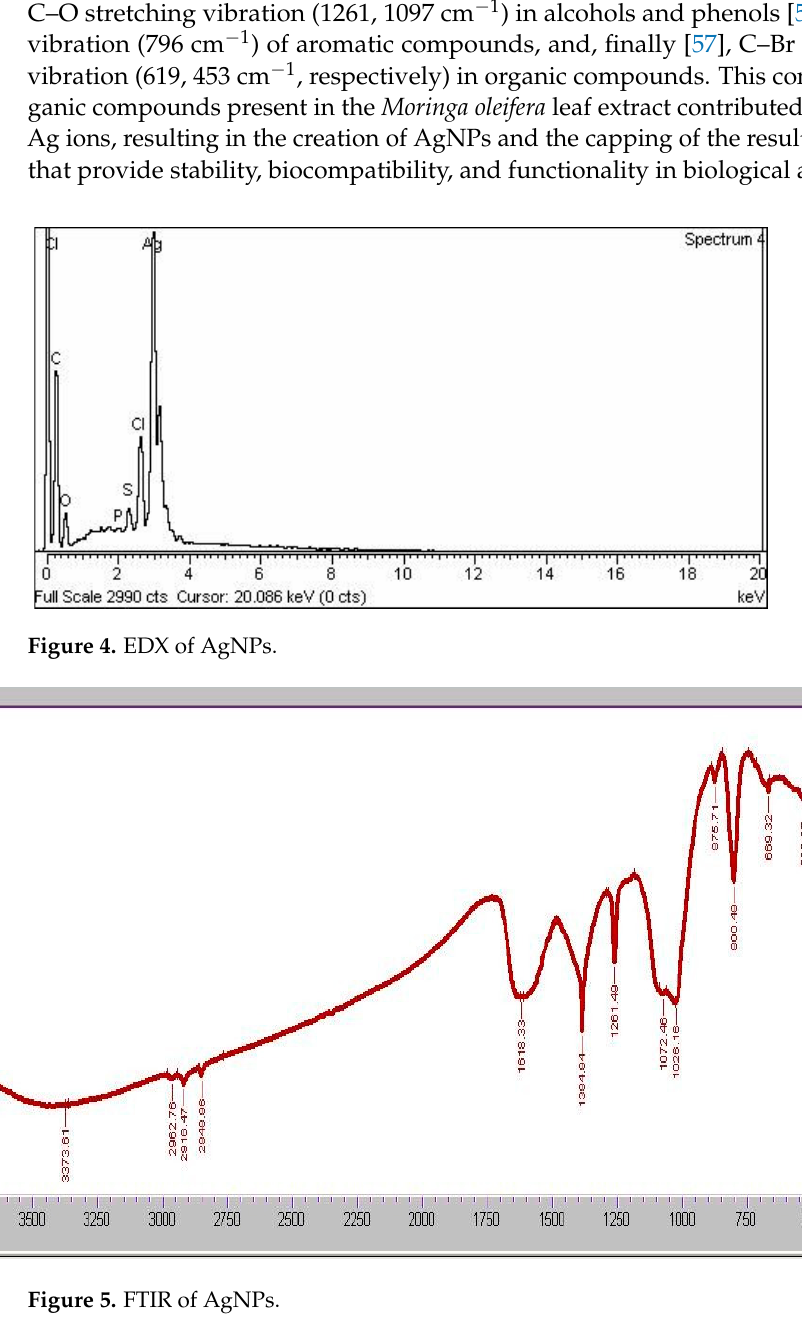
Figure 5. FTIR of AgNPs.